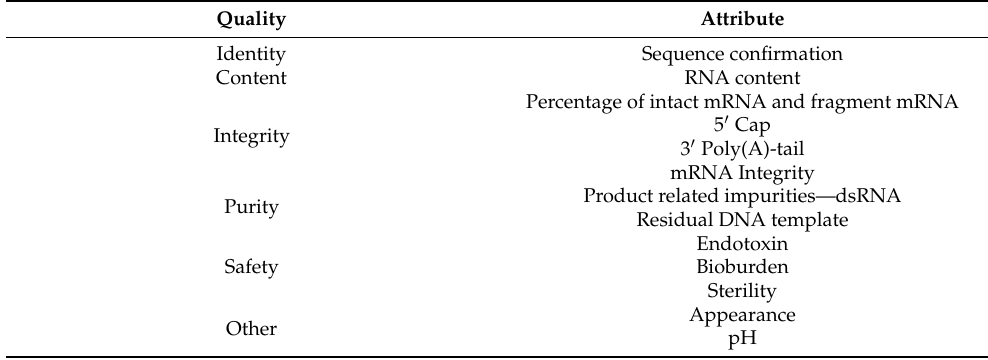
Table 3. Critical quality attributes for mRNA drug substances